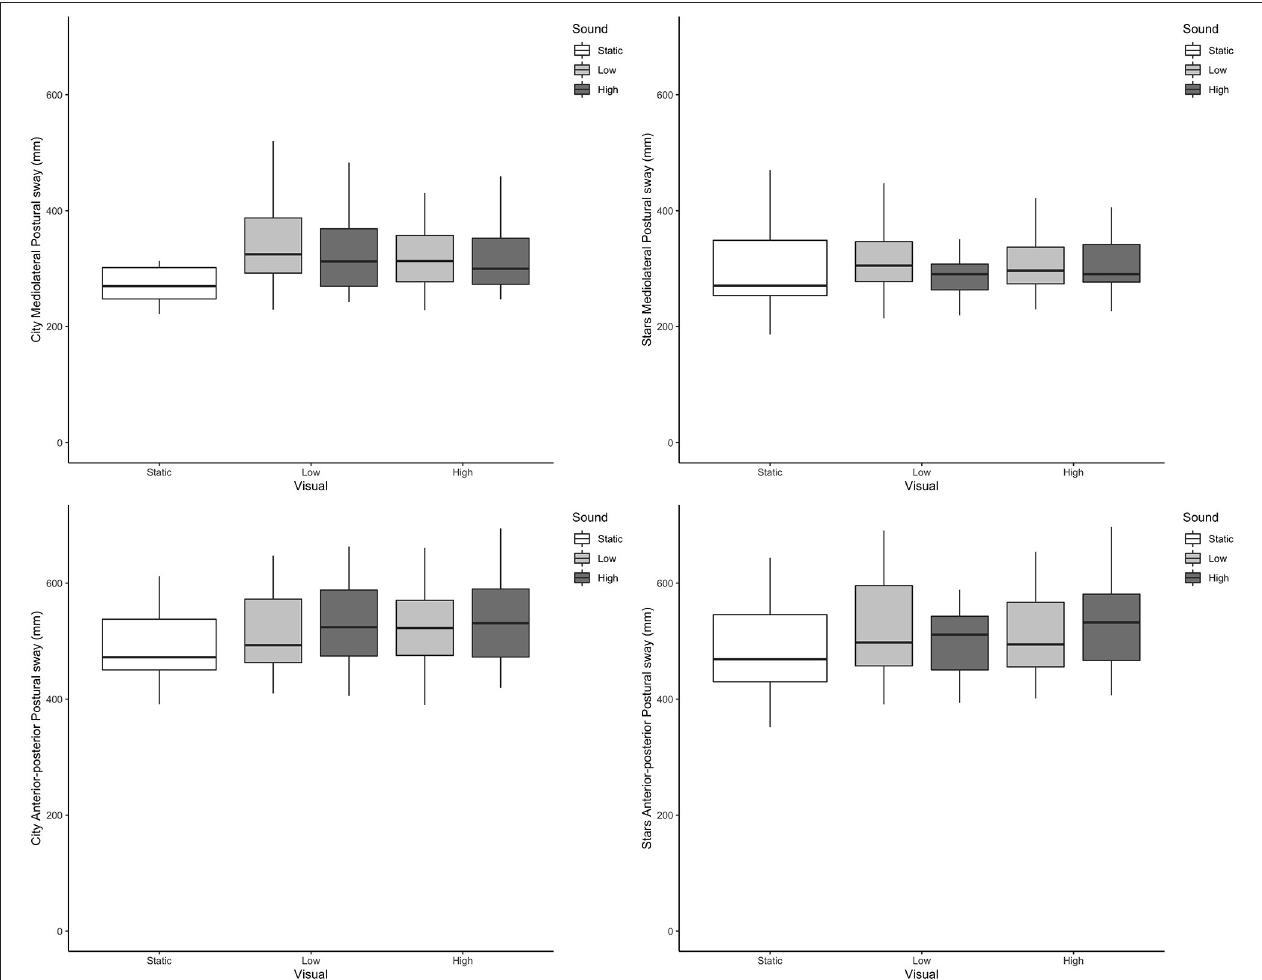
FIGURE 2 | Boxplots of postural sway directional path in mm (Y axis) across the different visual and auditory levels for the city scene (left-hand side) and stars scene (right-hand side) in the medio-lateral direction (top) and anterior-posterior direction (bottom).